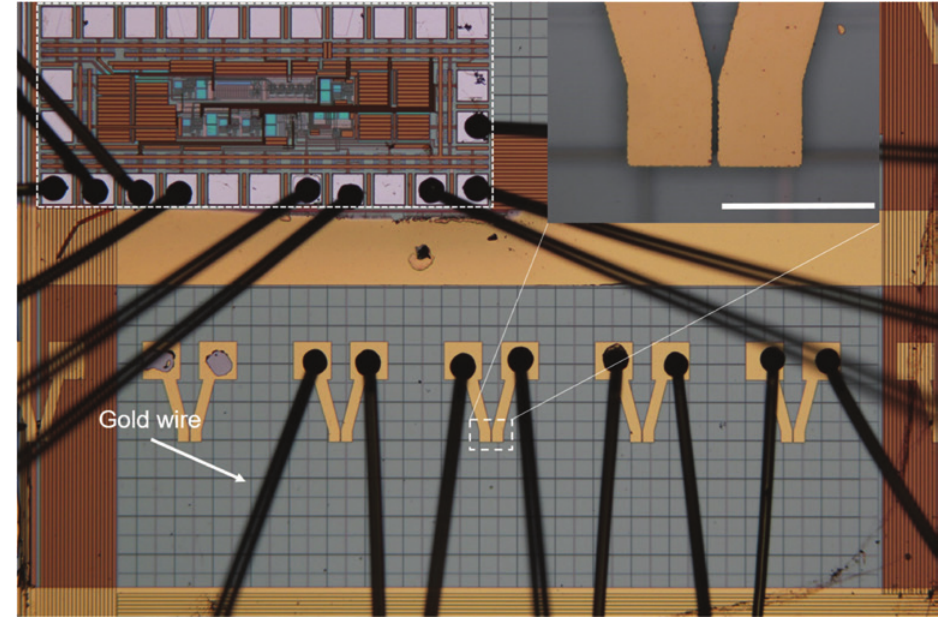
Fgure 3: Optical micrograph of the fabricated GPD-based monolithic optoelectronic integrated broadband optical receivers. The inset shows the GPD with more details and the scale bar is 50 μ m. The white dotted frame shows the location of the TIA